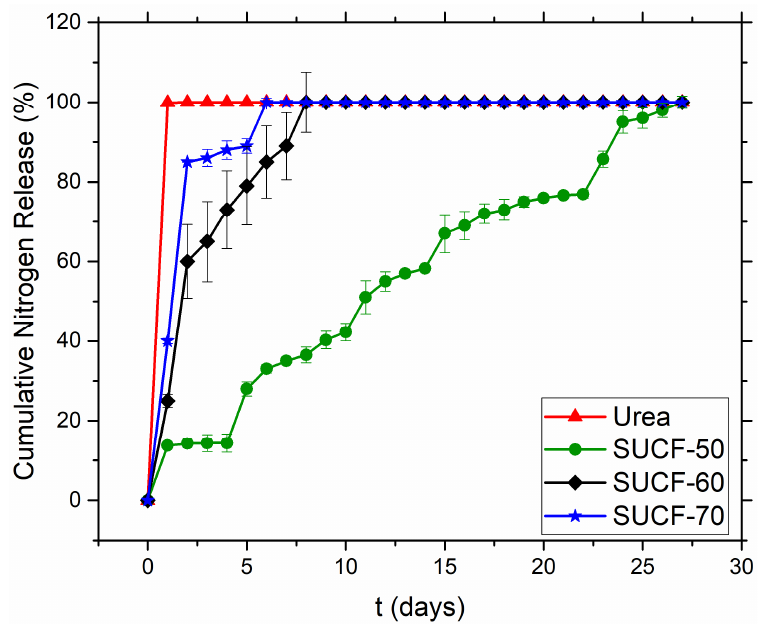
Figure 7. Cumulative nitrogen release vs. time (distilled water).